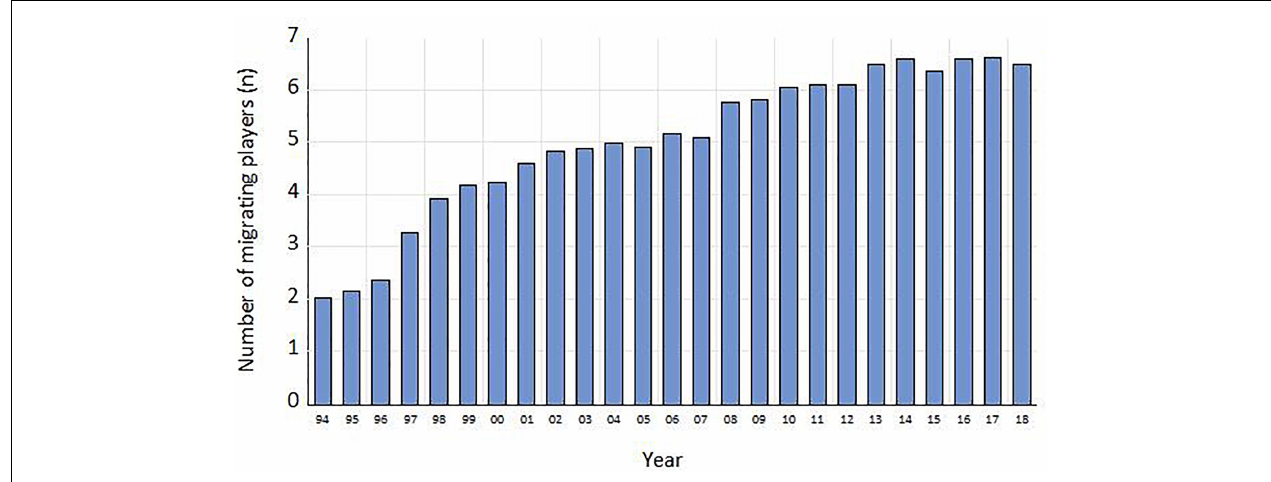
FIGURE 1 | Evolution of the average number of migrating players over time per